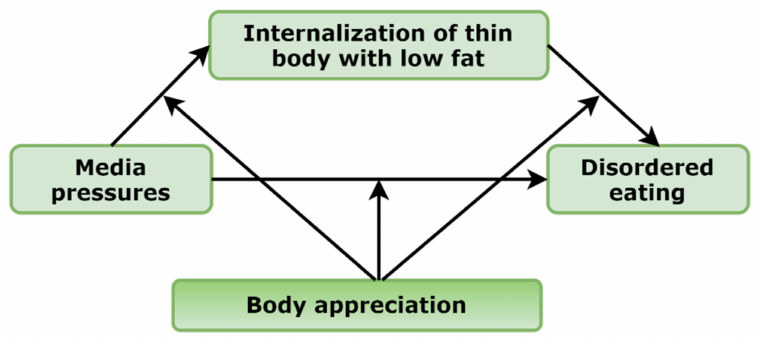
Figure 1. Hypothetical model of moderated